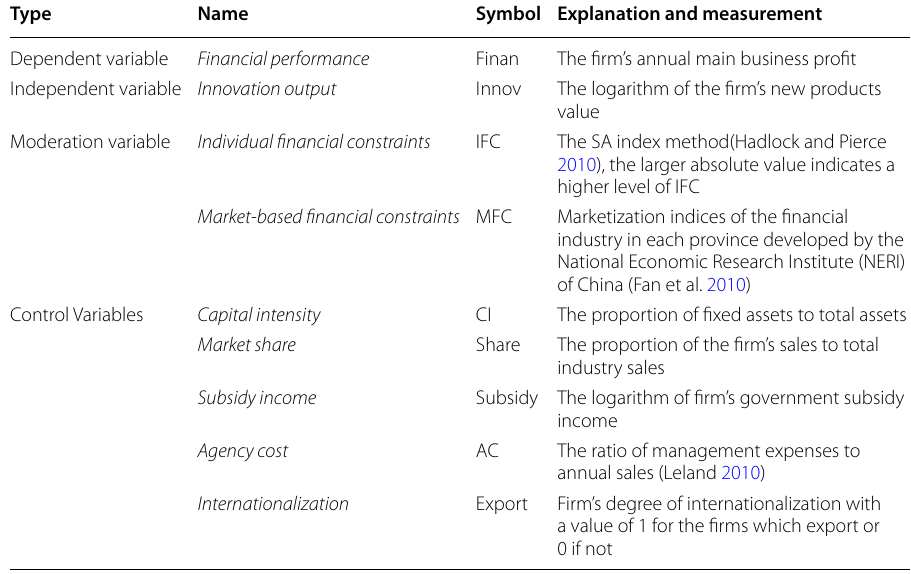
Table 1 Variables description summary